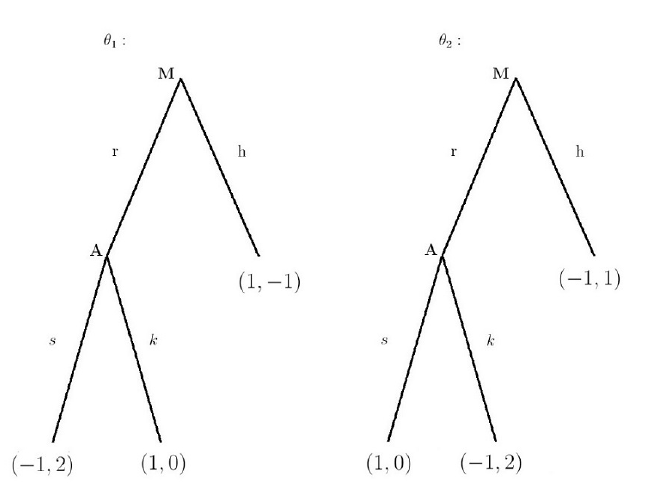
Figure 2. Case 2